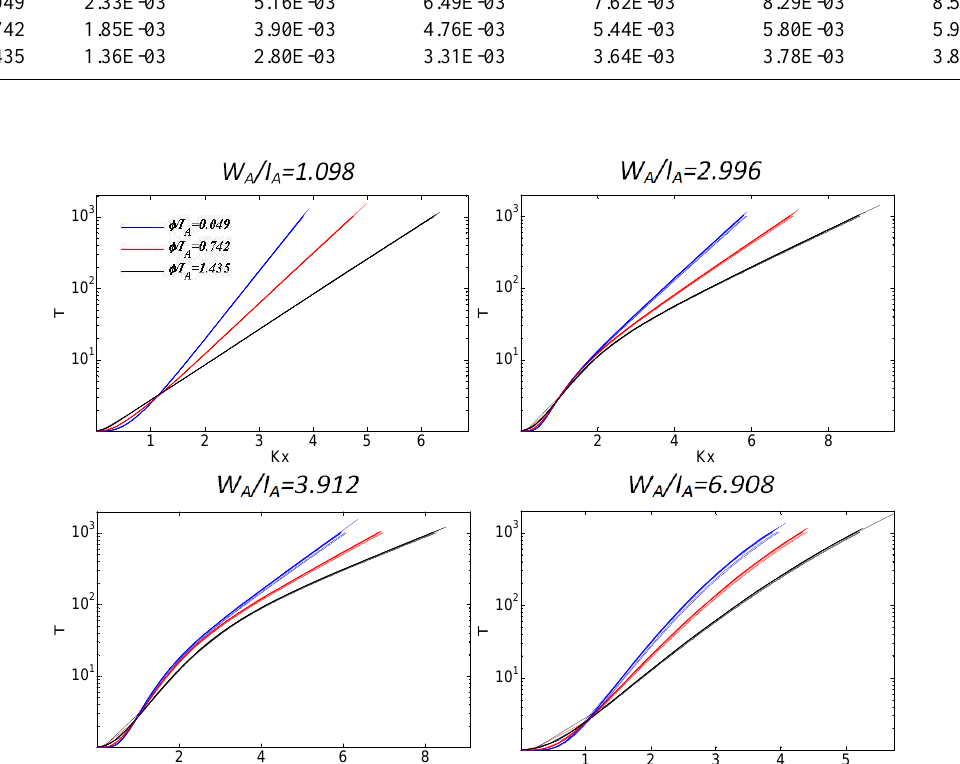
Fig. 2. Growth curves obtained for r L =0.1, r H =0.9, and different values of φ/I A (as in the legend), I 1 (10, 50mmh − 1 ), A (10, 50, 100, 200, 500km 2 ), W A /I A (in